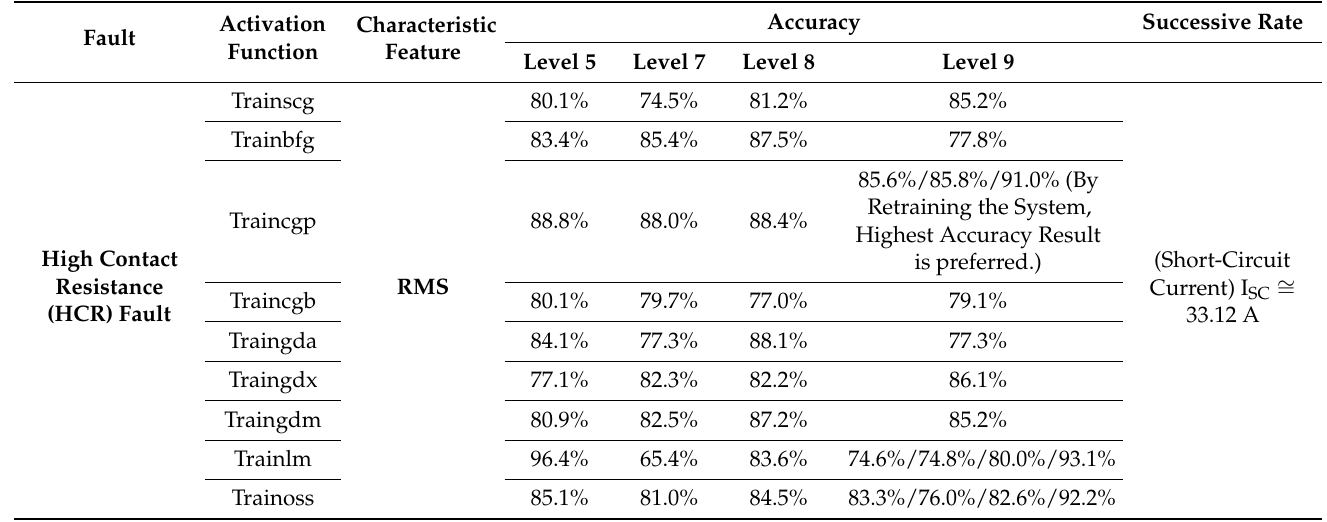
Figure 21. Neural Network Model ROC (Receiver Operating Characteristics) and Confusion Matrix for CGP TrainFcn/Activation Function at level 9 (RMS) Features for High Contact Resistance Fault with 91.0% Accuracy. Grey line shows diagonal of the ROC for indicating Class 1–6 lines are lying above or below or on it. Table 3. High Contact Resistance Fault with RMS Feature Accuracies under different Activation Functions .